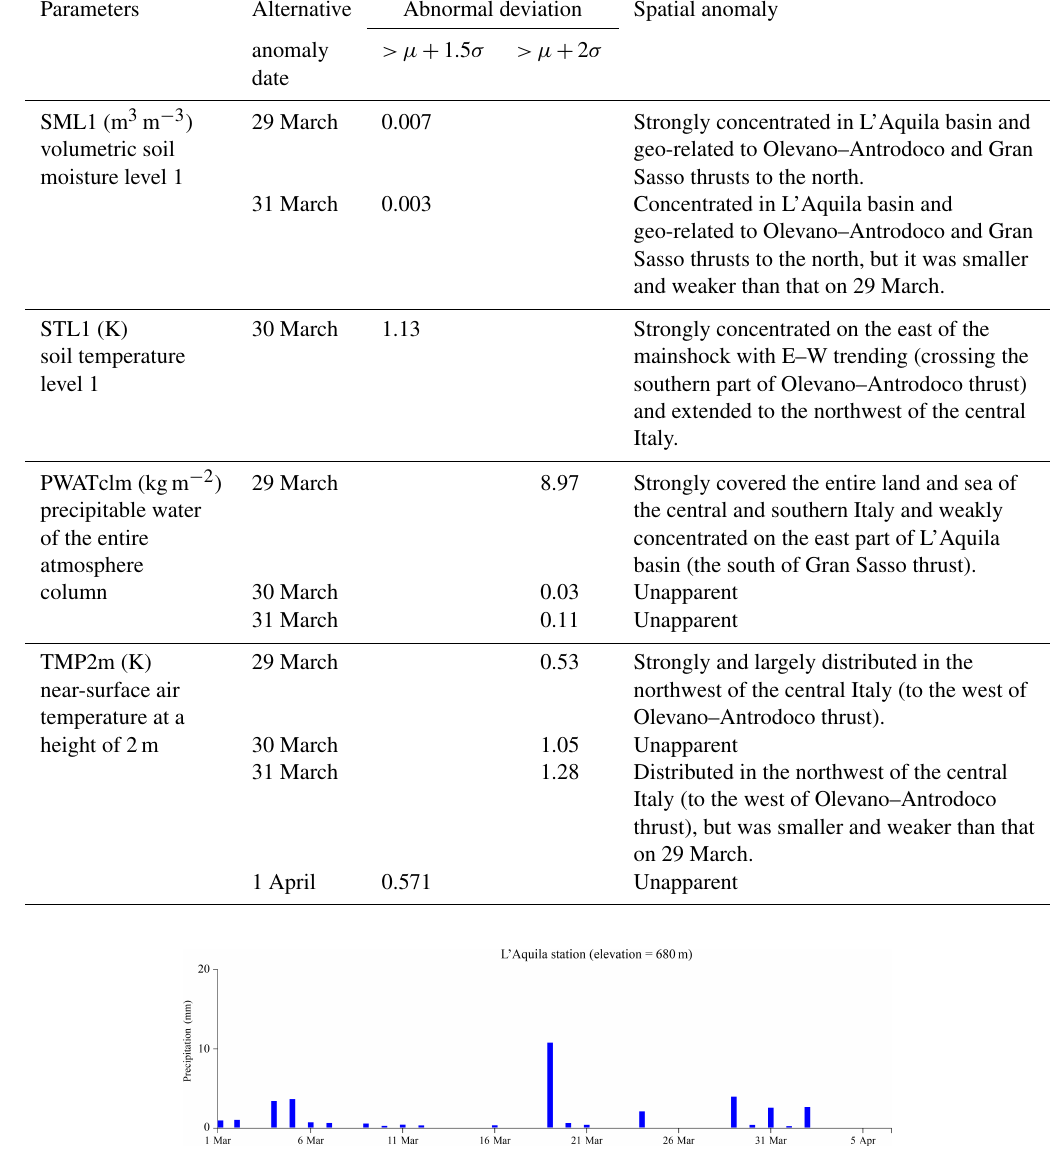
Figure 5. Daily precipitation at L’Aquila station from 1 March to 5 April